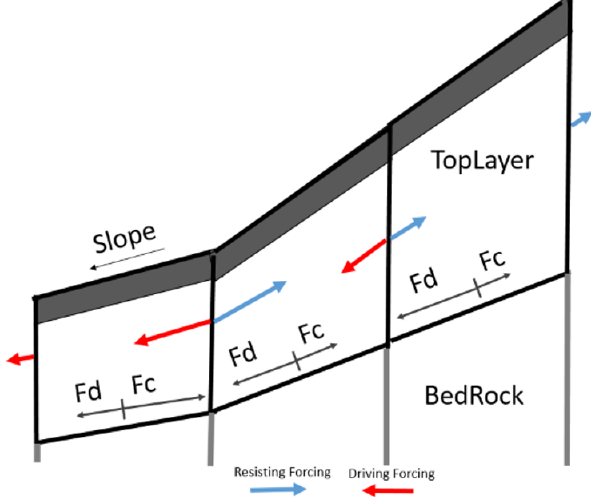
Figure 2. Subsurface force distribution is solved through iteratively finding a steady state (Fd = driving force, Fc = resisting